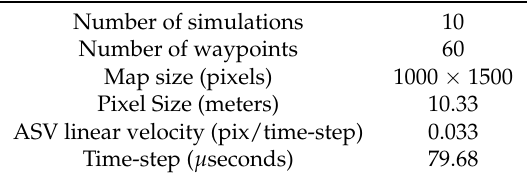
Table 1. Simulation